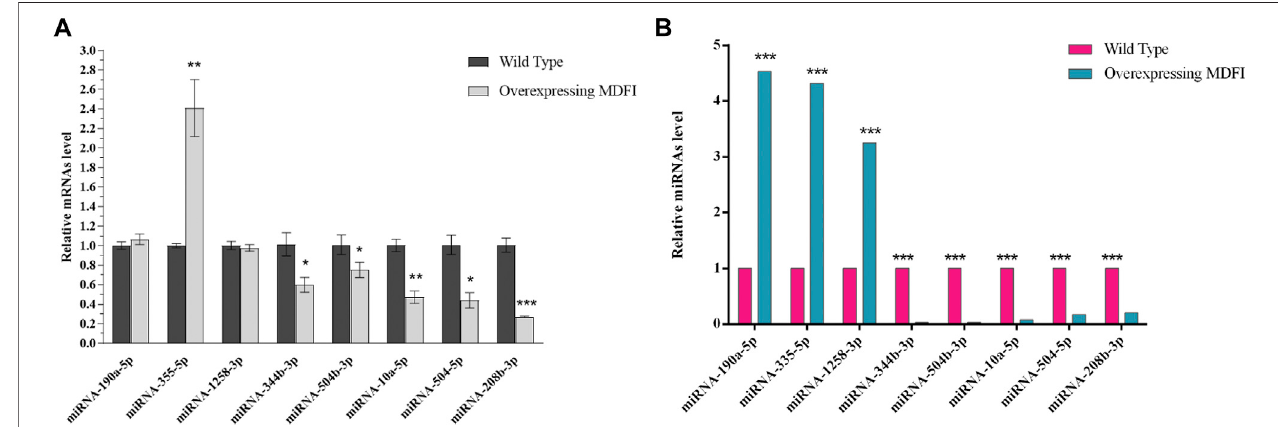
FIGURE 2 | Quantitative RT-PCR validation. (A) . qRT-PCR validated of DEMs. (B) . Expression levels of DEMs in miRNA-seq. ** p < 0.01, *** p <